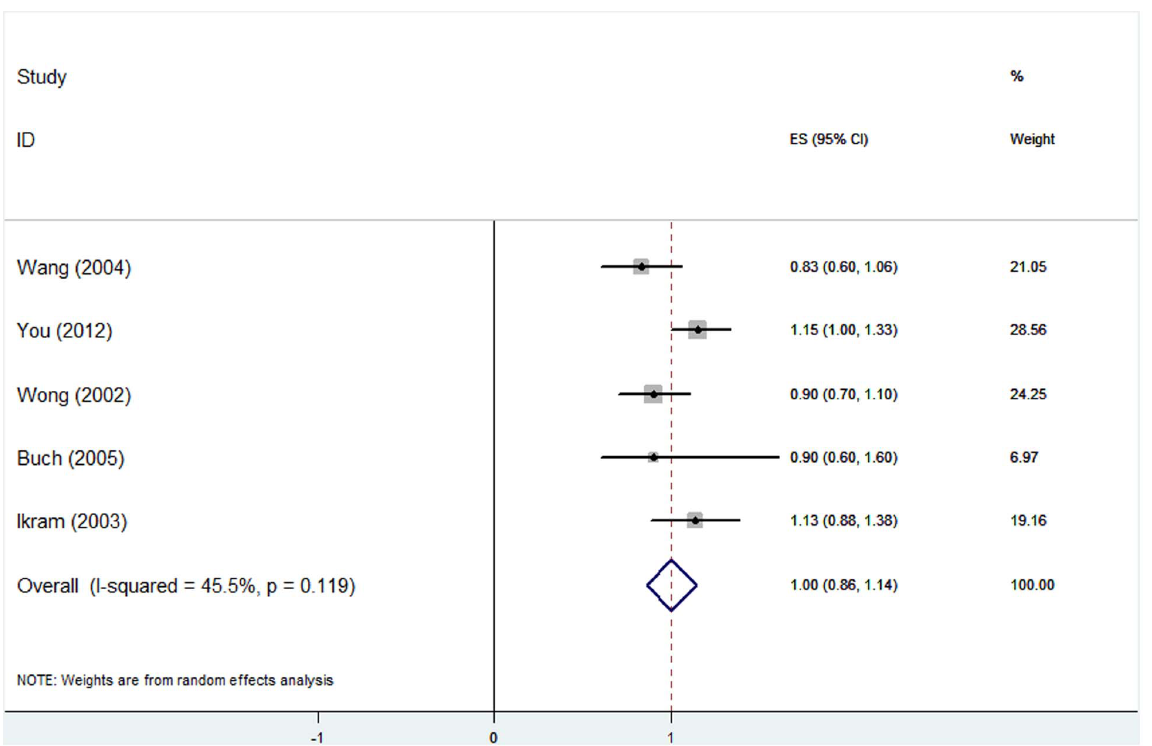
Figure 3. Hyperopia and early AMD incidence: forest plot of pooled odds ratios for the random-effects meta-analysis of early AMD incidence and hyperopia. CI, confidence interval.